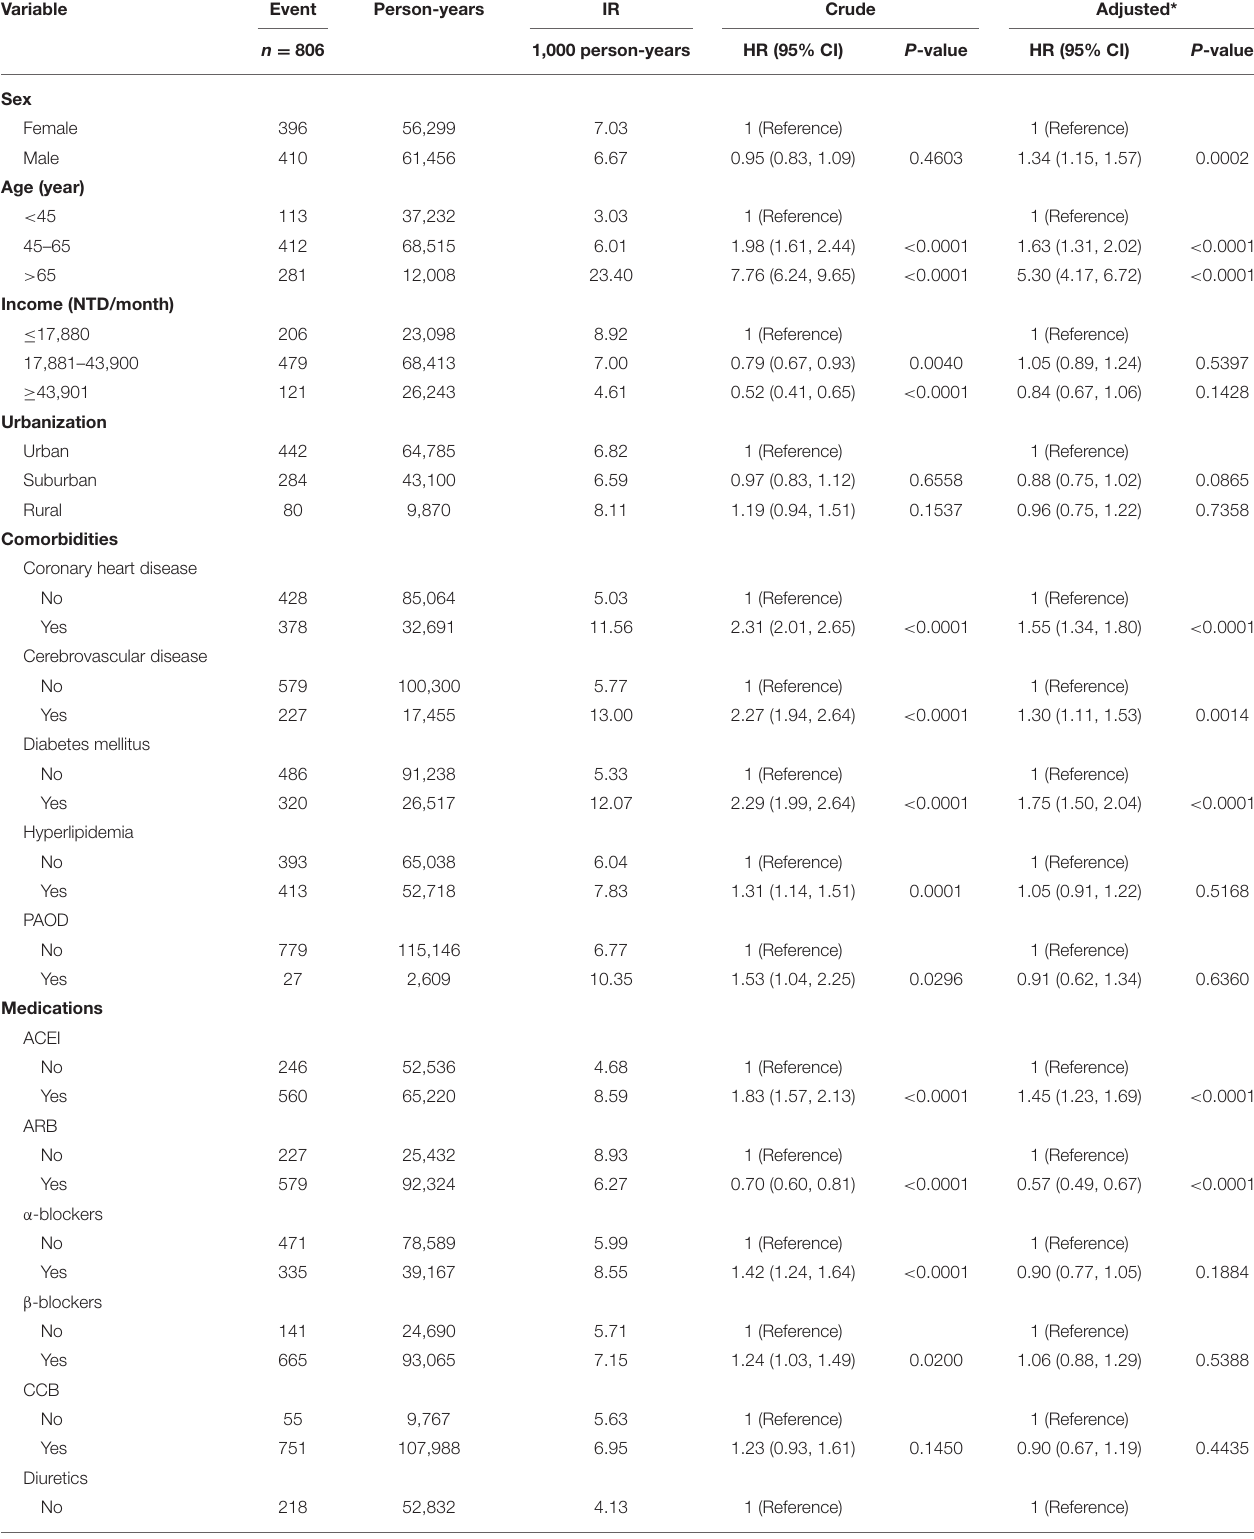
TABLE 3 | Cox regression analyses of heart failure associated with covariates among hypertensive patients.